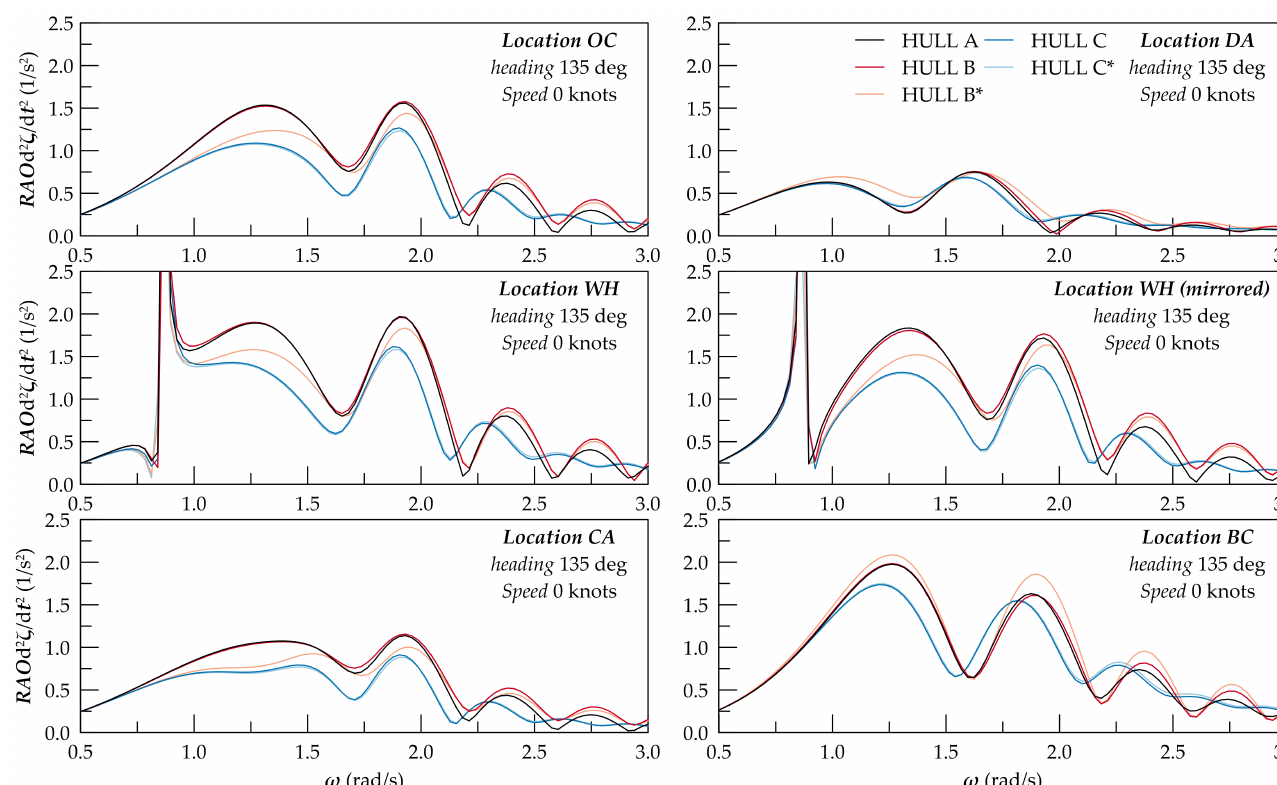
Figure 14. Absolute lateral acceleration RAO at 12 knots on the reference hulls for the AWI locations.